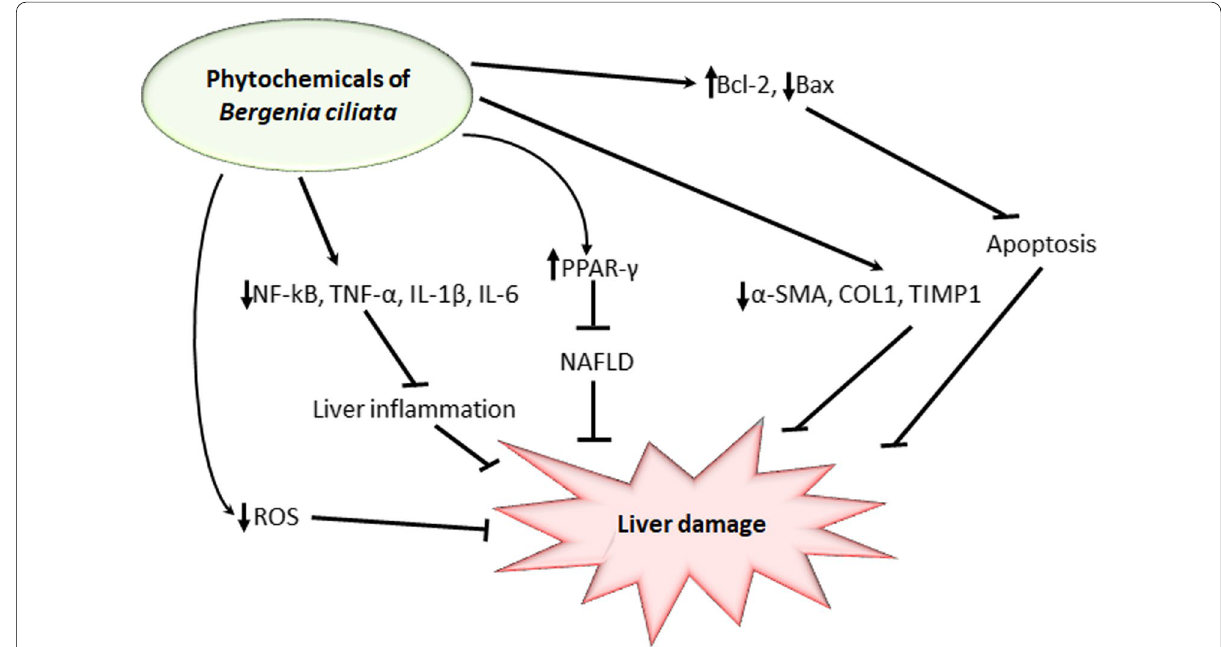
Fig. 3 Mechanism of protective action of Bergenia ciliata against liver